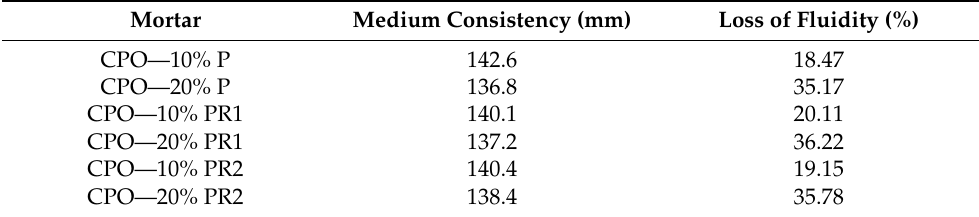
Table 1. Consistency of mortars made with different waste additions. (CPO = Cement Portland Ordinary).